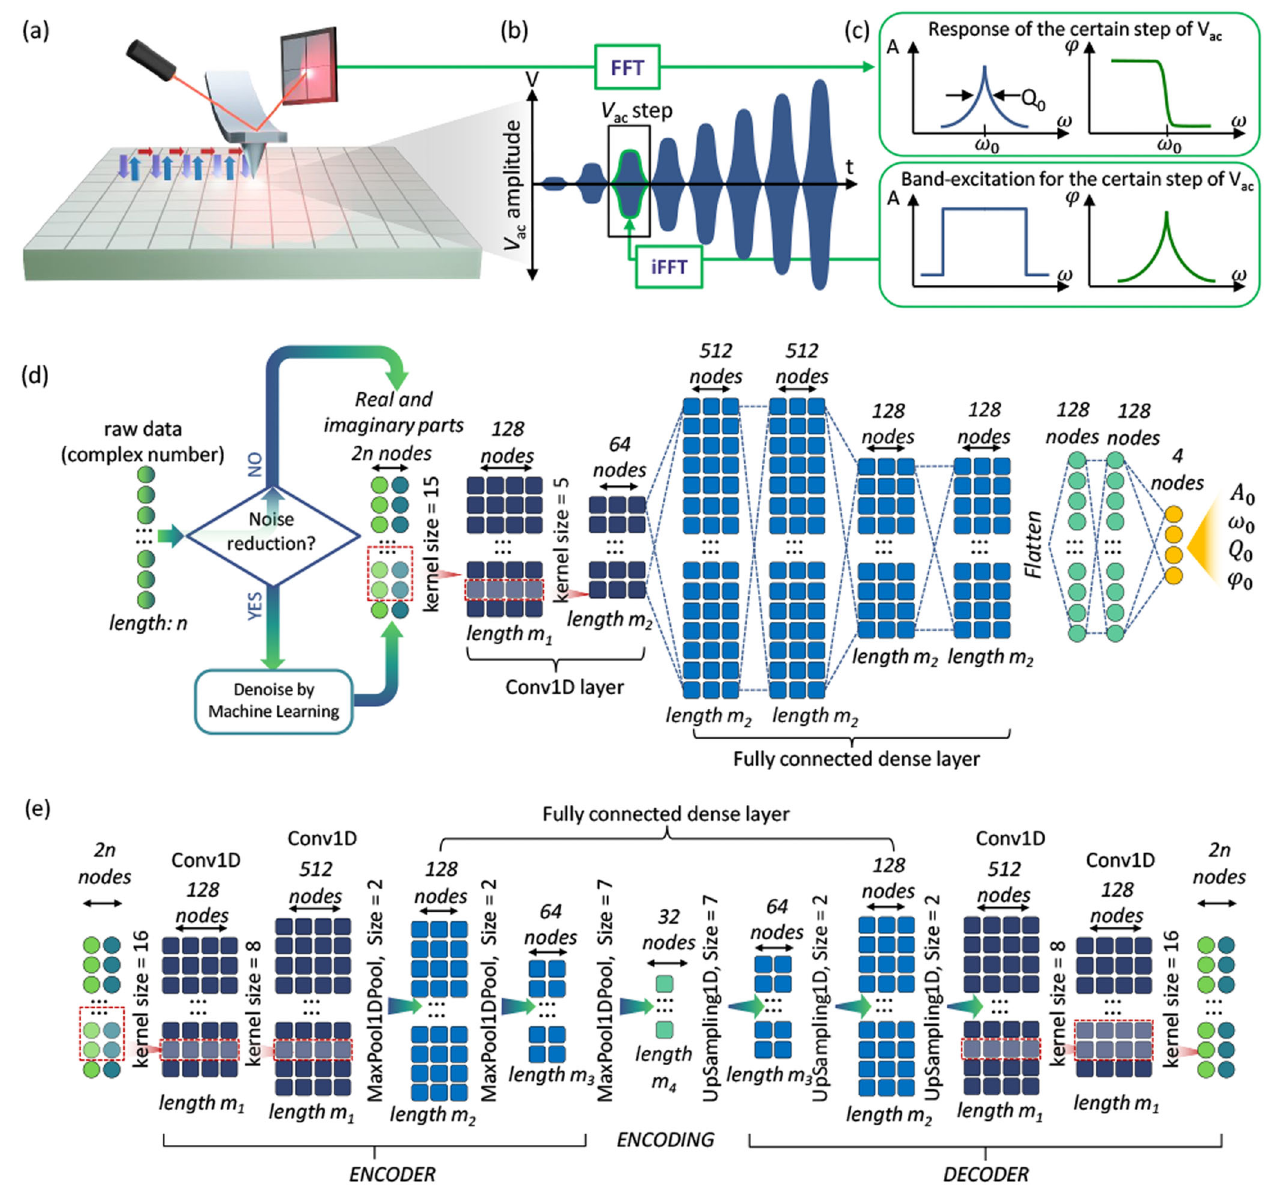
Fig. 1 Scheme of the PFM measurements integrated with deep learning. a PFM spectroscopy measurement where the resonance spectrum records pixel-by-pixel while the probe moves according to the mapping positions. b The waveform for the V ac amplitude sweep consists of the BE waves with a prede fi ned frequency range across the contact resonance frequency and different V ac amplitudes ( V ac steps). During the measurement, the cantilever oscillation induced by the waveform is acquired at every pixel as the PFM dataset. After the FFT, the piezoresponse oscillation spectrum of a complex value can be converted into ( c ) amplitude and phase as a function of frequency, and every single datum in the dataset can be indexed by the row, column, V ac step, and frequency bin. d Schematic of the DNN work fl ow with the noise reduction element. e Schematic of the noise reduction element of the DDA, the component of encoder, encoding, and decoder layers, in which the type and dimensionality are speci fi ed on the top of the layer. The DNN and DDA input data are a stacked 2 × N matrix of the real and imaginary parts of the piezoresponse